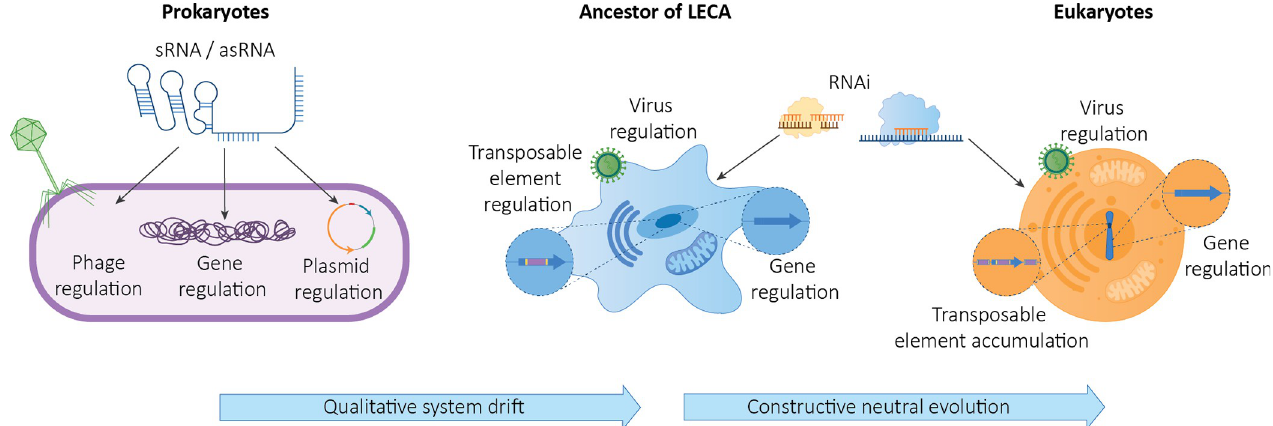
Fig 1. Evolution from prokaryotic RNA-mediated gene regulation to eukaryotic RNAi. We propose that the evolutionary journey from prokaryotic RNA- mediated gene regulation to eukaryotic RNAi comprised 2 distinct evolutionary process. The first involved changes in the molecular machinery without changes in the final outcomes of the process (qualitative system drift). The second involved a ratcheting cascade caused by the suppressive role of RNAi on the deleterious effects of TEs, as postulated by CNE. asRNA, antisense RNA; CNE, constructive neutral evolution; LECA, last common eukaryotic ancestor; RNAi, RNA interference; sRNA, small RNA; TE, transposable